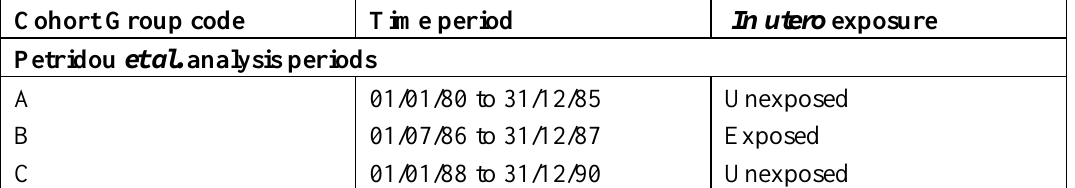
Table 1. Exposure categories and time periods employed in the present